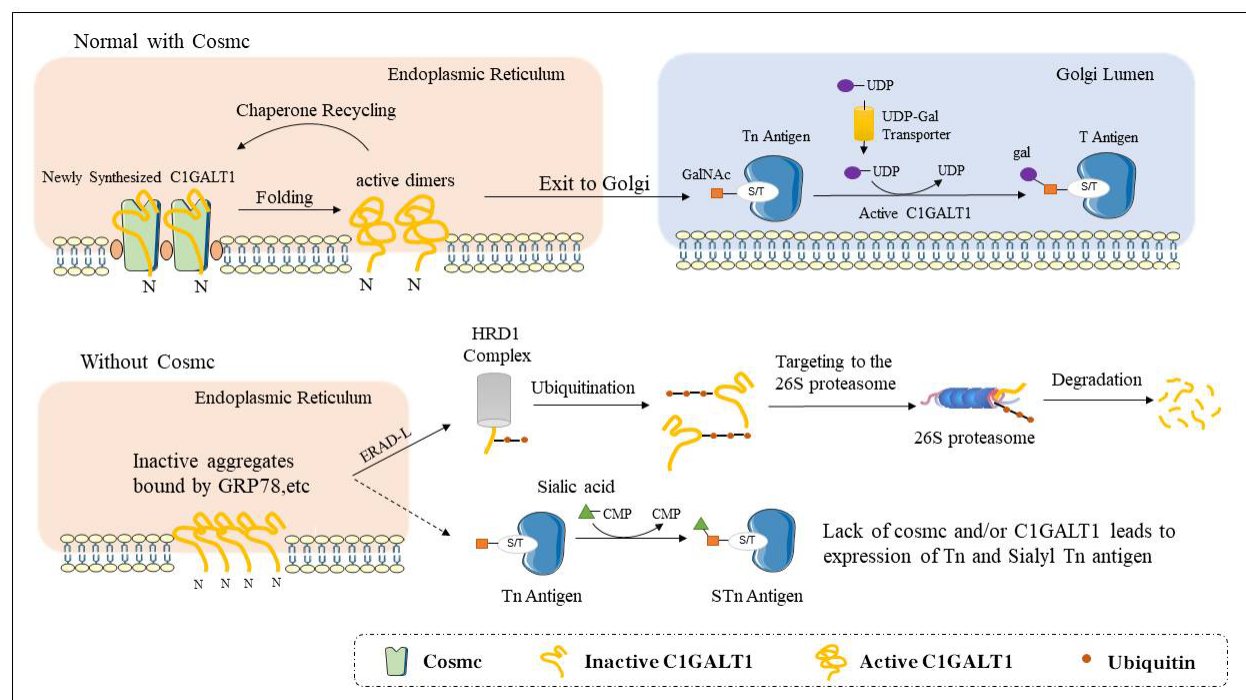
Figure 3. Working model for Cosmc function. Human Cosmc is located in the ER, where it interacts with the activated C1GALT1. Activated C1GALT1 is inserted into the Golgi apparatus and is involved in the synthesis of core-1 O-glycans (T antigens). When Cosmc is mutated and dysfunctional, misfolded C1GALT1 aggregates in the endoplasmic reticulum and is retrotranslocated from the endoplasmic reticulum to the cytosol, where it is ubiquitinated and degraded by the proteasomal machinery.